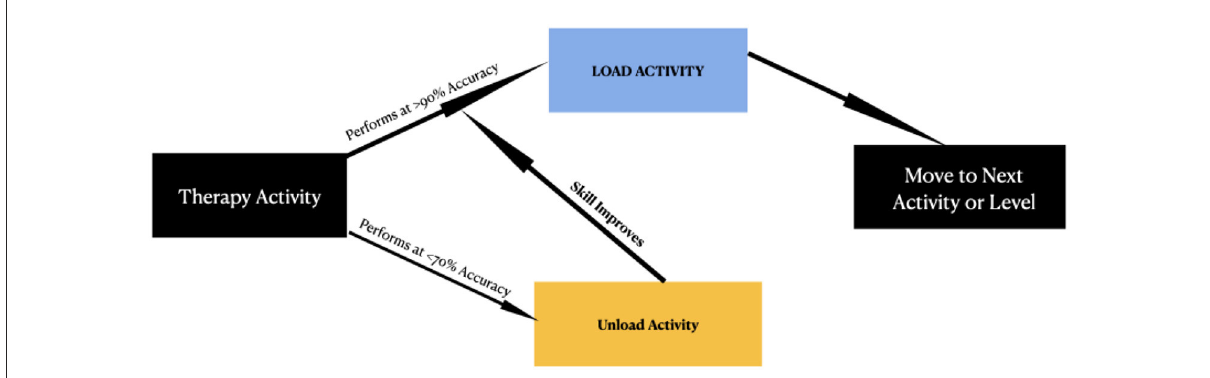
FIGURE1 A decision tree for determining the next course of action for NORT